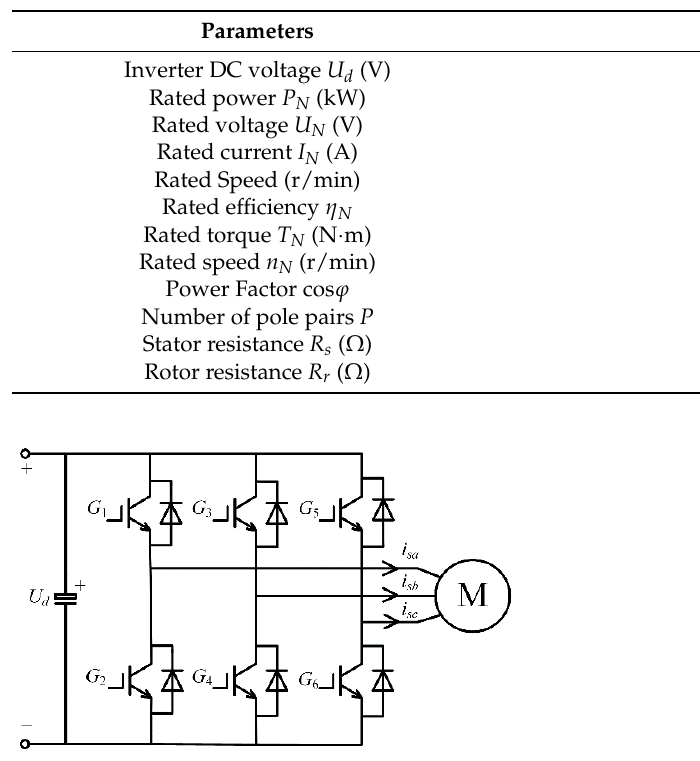
Table 2. Induction motor simulation parameters.